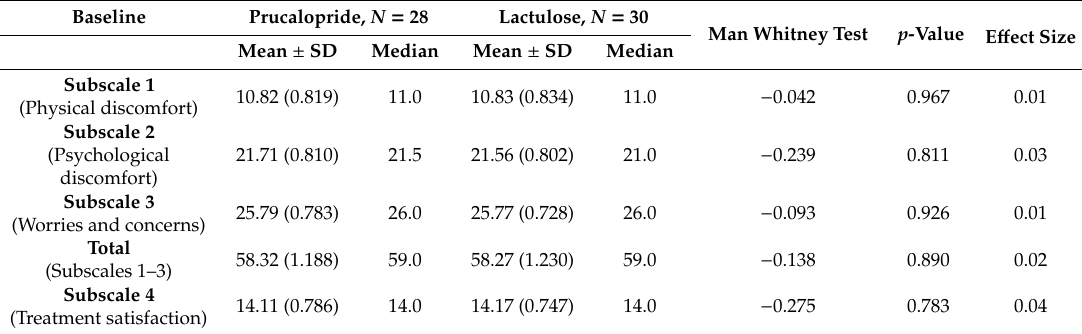
Table 4. PAC-QOL assessment at the end of the 4 weeks study intervention. Table 3. Patient assessment of constipation—quality of life (PAC-QOL) assessment at baseline.